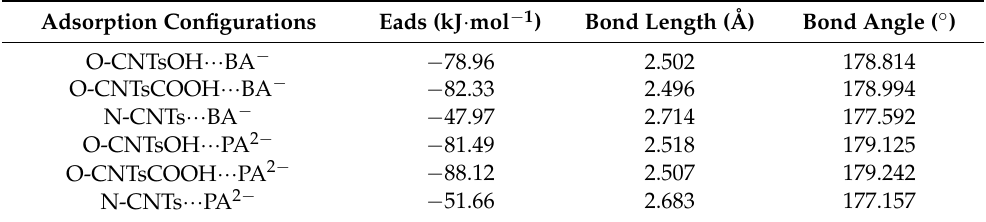
Figure 6. The Binding energy (E ads , kJ·mol-1), bond length (Å ) and bond angle (°) of charged assisted H-bonds (CAHBs) between CNTs and IOCs. The shorter bond length and the closer linear bond angle (180°) indicate the stronger H-bond, and the strength order of CAHBs is Homonuclear CAHB (A, B, D, E) > Heteronuclear CAHB (C, F). Table 1. The binding energy (Eads, kJ·mol -1 ), bond length (Å ) and bond angle (°) of charged assisted H-bonds for BA and PA adsorption on O-CNTs and N-CNTs.